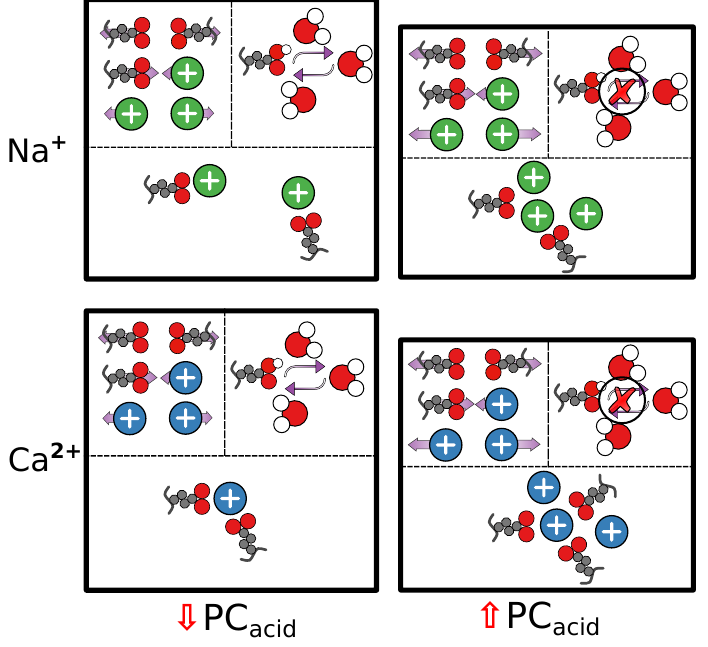
Figure 11. Schematic summary of the main properties of the system depend on the low and high levels of PC acid and the counterions Na + and CA 2 + . Each system contains three parts. The first ( top left ) describes the pair of interactions that contributes largely to the potential energy of the system (carboxyl groups of HS, carboxyl group of HS with counterion, and the interaction between cations). The second ( top right ) describes the interaction of water molecules with protonated carboxyl groups of HS. The third ( down , center ) is the presence of salt bridges and ways of interaction between carboxyl groups and